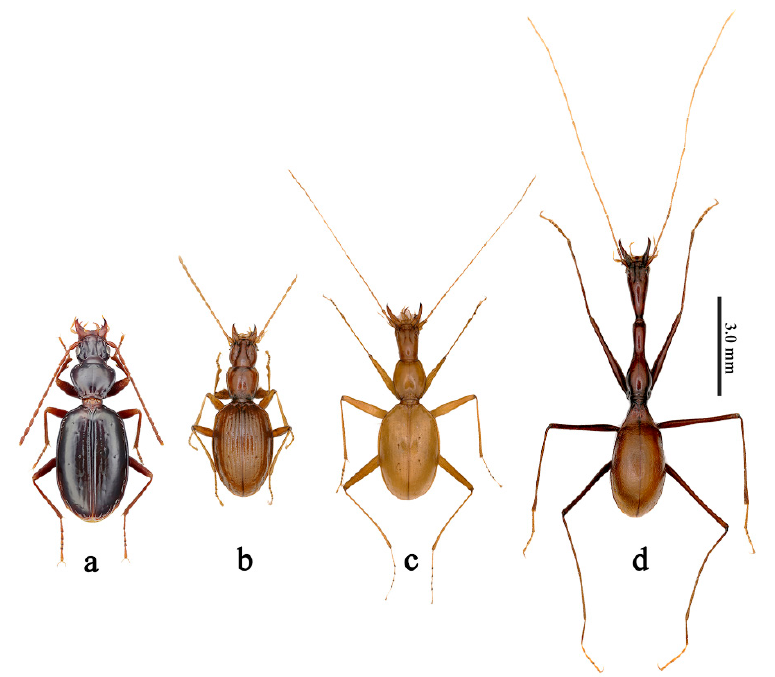
Figure 1. Morphological characteristics of four different adaptive types of ground beetles. ( a ) Surface-dwelling ( Sinotrechiama yunnanus ); ( b ) anophthalmic ( Sinotroglodytes yanwangi ); ( c ) semi- aphaenopsian ( Aspidaphaenops dudou ); and ( d ) aphaenopsian ( Giraffaphaenops clarkei ).